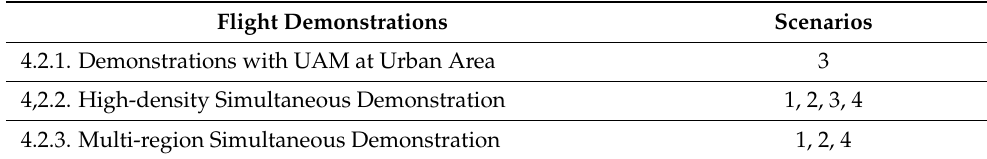
Table 5. Scenarios used in flight demonstrations.